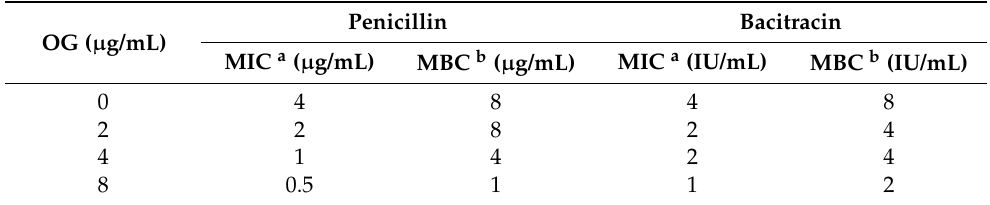
Table 1. Synergistic bacteriostatic and bactericidal activities of octyl gallate (OG) and antibiotic combinations against Staphylococcus epidermidis